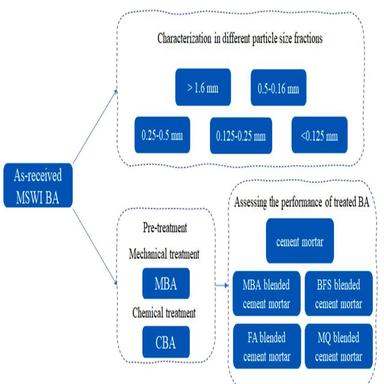
Flowchart of the testing program for this study.